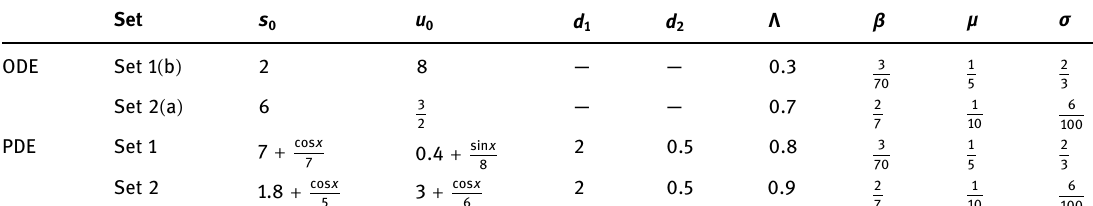
Table 2: Simulation parameters for Example 2